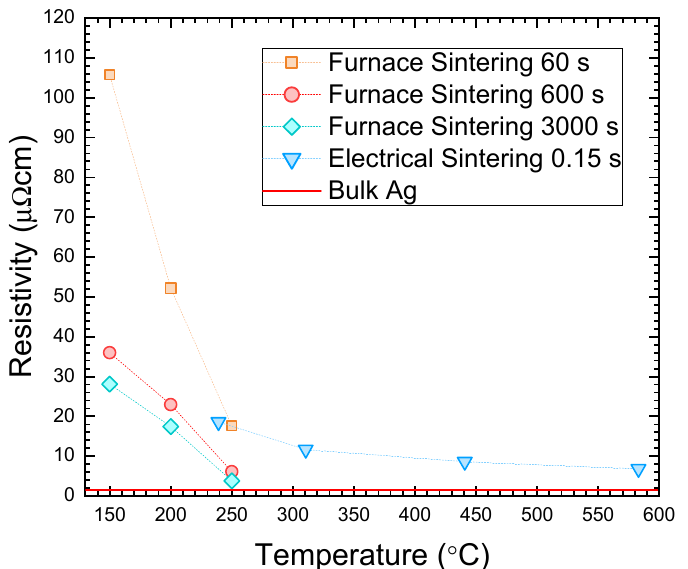
Figure 8. A comparison among furnace sintering results at different sintering durations against the SCIS technique results of the final-step currents at 0.15 s.